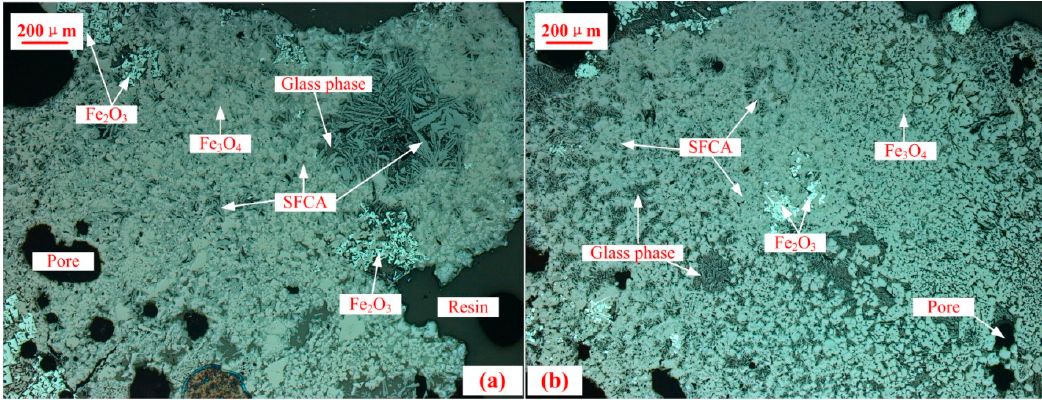
Figure 4. ( a ) Microstructures of sinter containing 1.36% MgO; ( b ) microstructures of sinter containing 3.10% MgO.